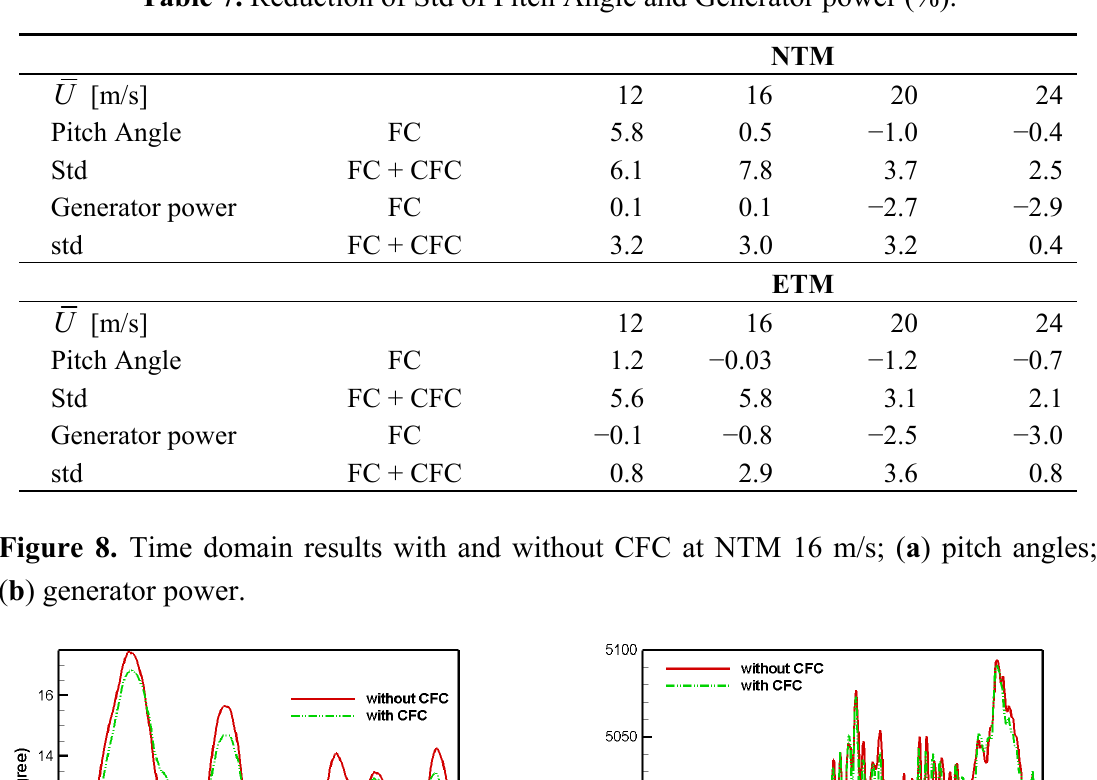
Table 7. Reduction of Std of Pitch Angle and Generator power (%).